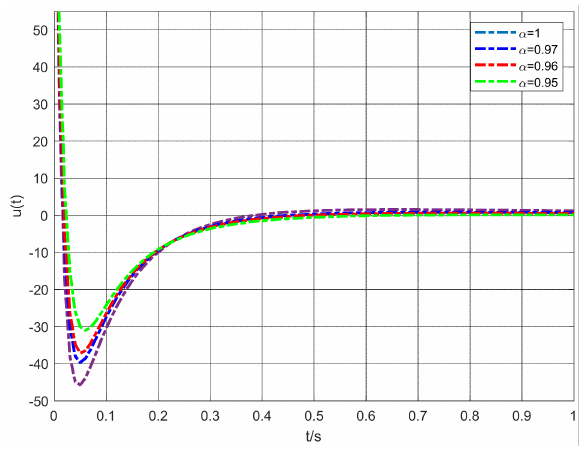
Figure 3. The system control